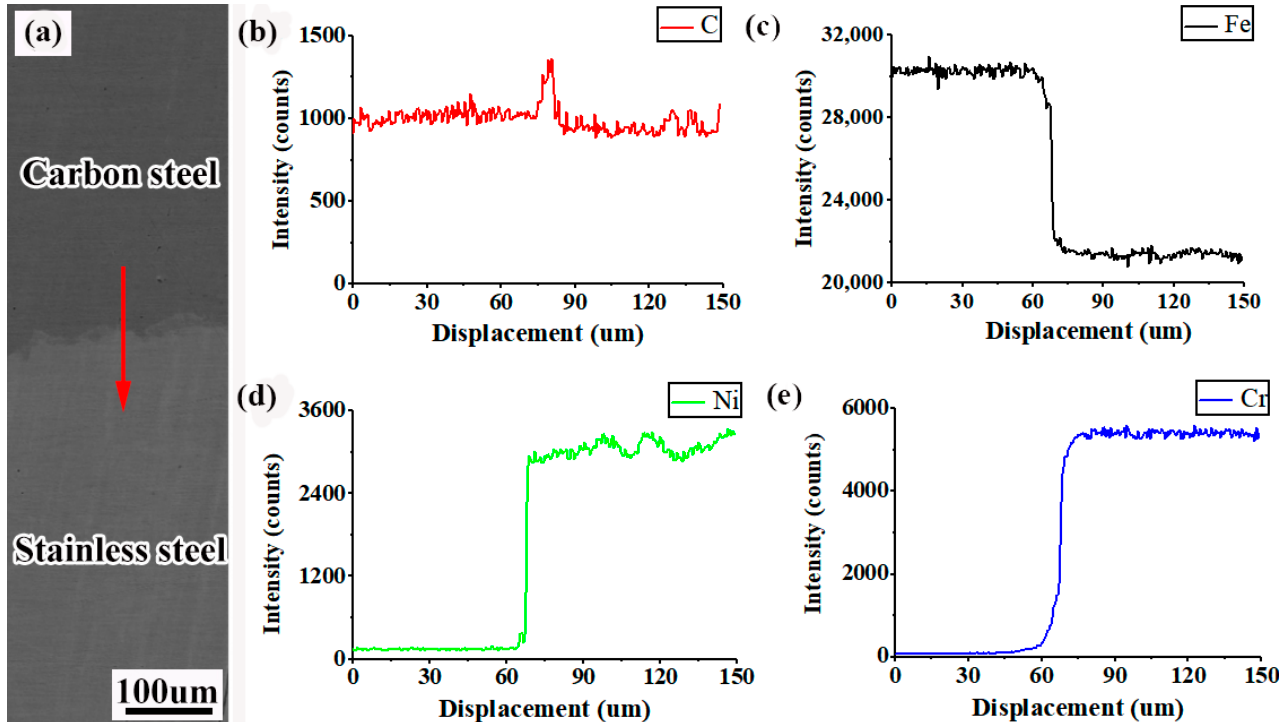
Figure 10. Composite interface electron-probe results: ( a ) EPMA line-sweep position; ( b ) C; ( c ) Fe; ( d ) Ni; ( e )